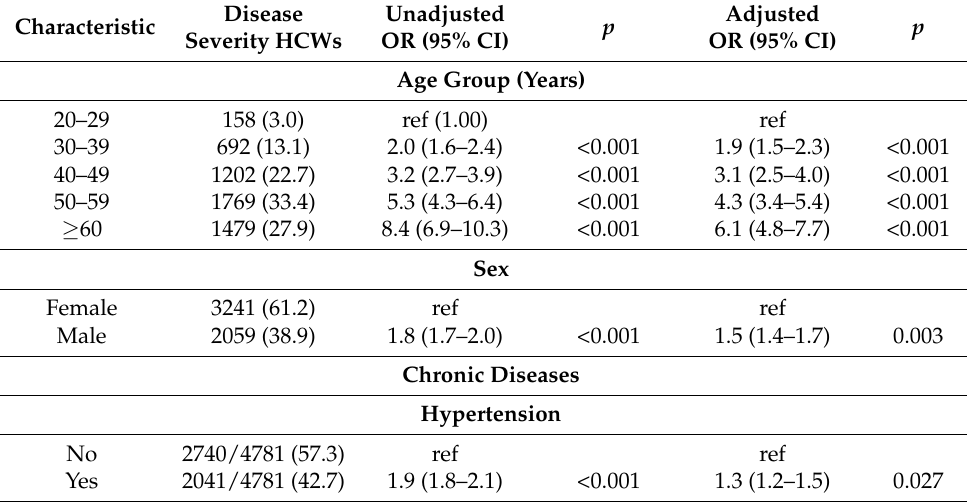
Table 2. Factors associated with disease severity among HCWs admitted with COVID-19 ( N =